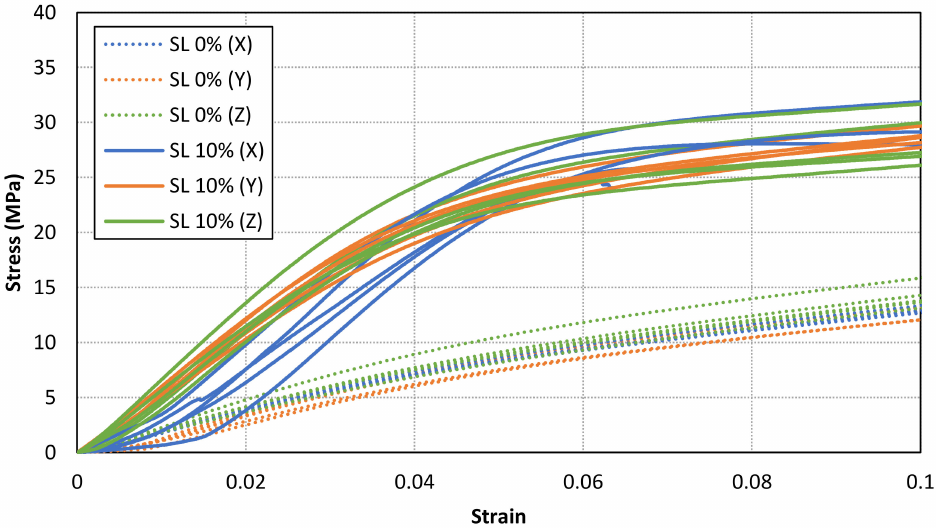
Figure 10. Comparison of stress-strain curves for all tested specimens with a solid load content of 0% and 10%. Similar stress-strain curves are found for different orientation samples with the same solid load